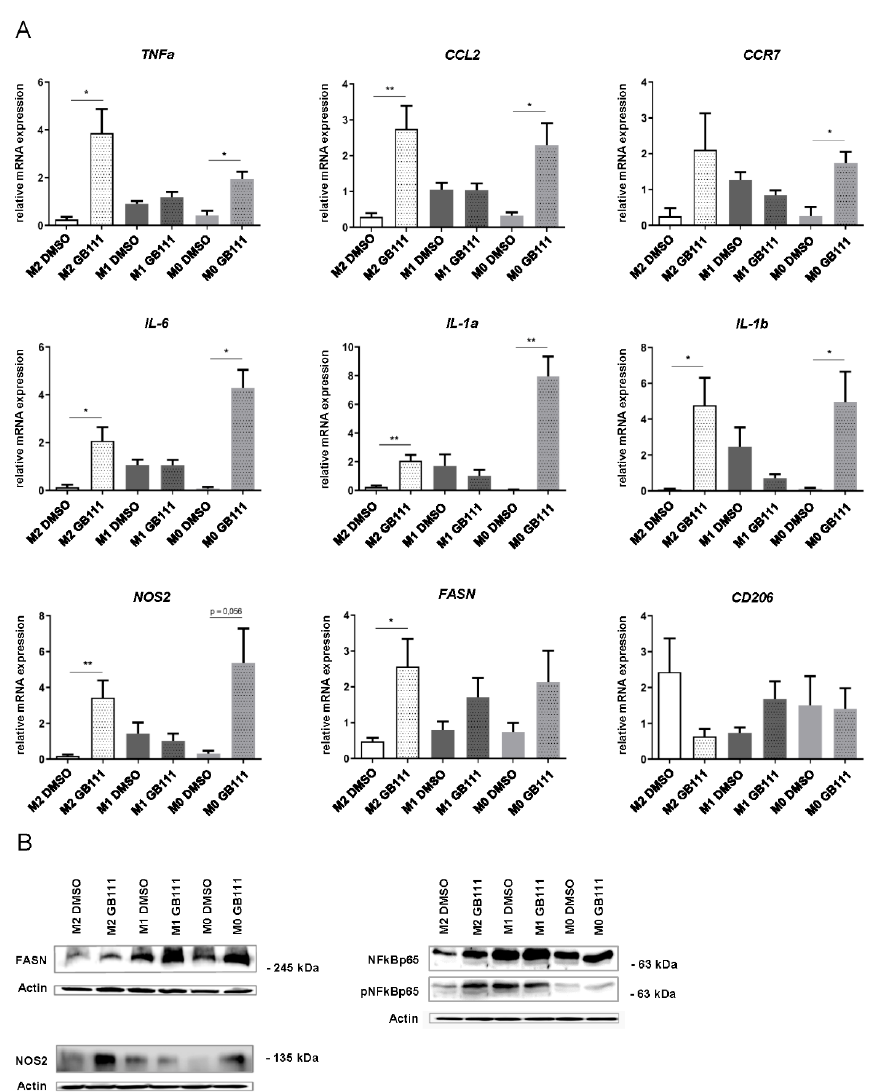
Figure 6. ( A ) Inhibition of cathepsin B, L, and S activity correlates with changes in the expression profiles of the M1 associated marker genes TNF α , CCL2 , CCR7 , IL-6 , IL-1a , IL-1b , NOS2, and FASN , as well as the M2 marker CD206 , as determined by real-time PCR. Data are presented as mean ± standard deviations (SD) and p -values below 0.05 were considered to be statistically significant (* p ≤ 0.05; ** p ≤ 0.01; *** p ≤ 0.001). ( B ) Representative immunoblots showing the expression of the M1 associated markers fatty acid synthase (FASN), nitric oxide synthase 2 (NOS2), and the detection of phosphorylated and total NFkBp65. Data are representative for at least three independent experiments, and β -actin served as loading